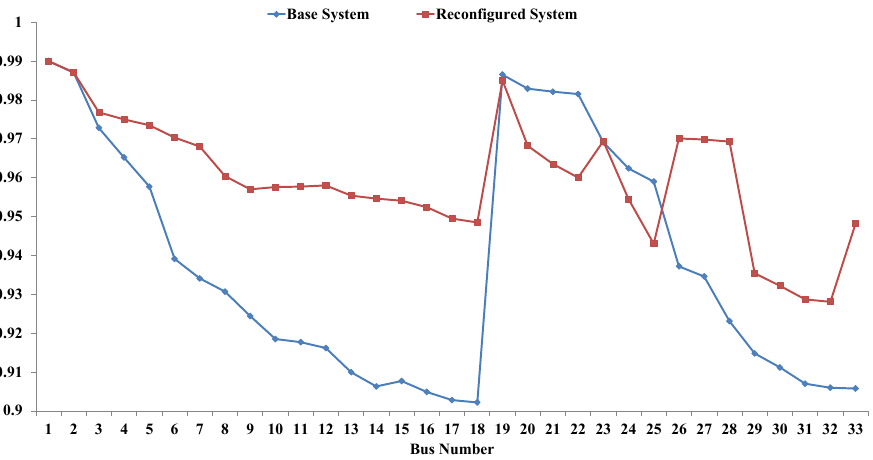
Figure 5. Voltage profile of base and reconfigured distribution system.